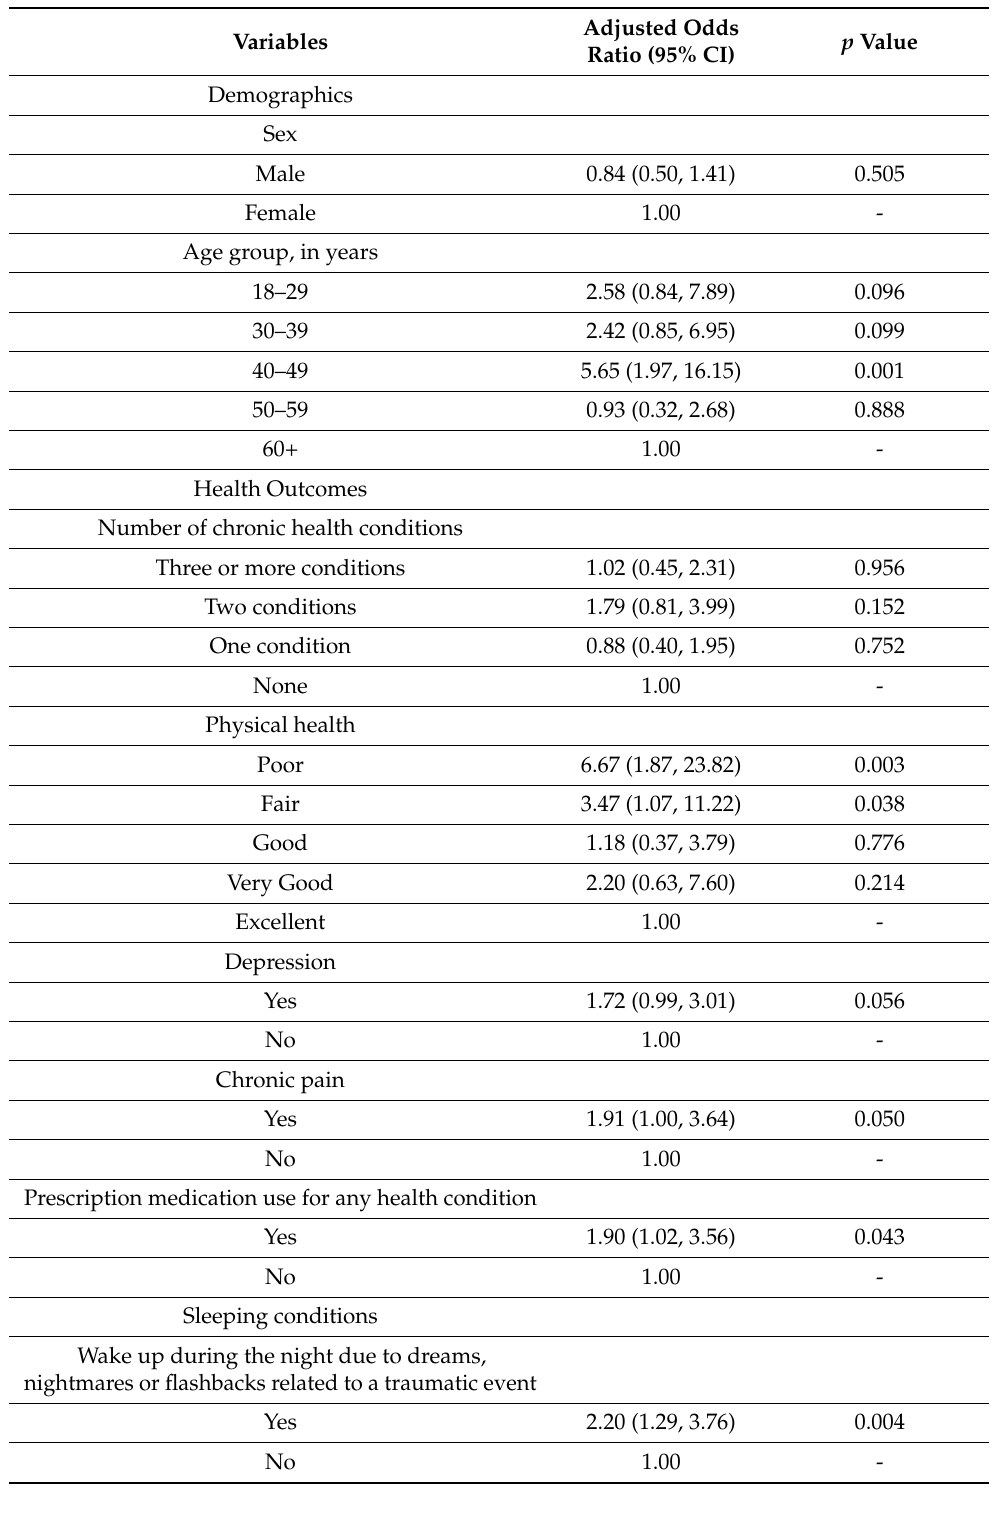
Table 4. Multivariable Associations between insomnia based on ISI score ≥ 15 and risk factors and odds ratio and 95% CI ( n =